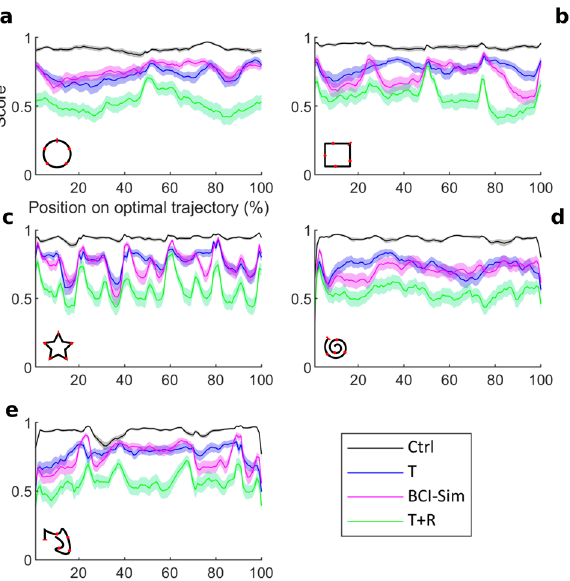
Figure 7. All participants’ mean scores across the target shape. The mean score is shown against the position on the optimal trajectory in percent (see Material and Methods). The data is shown for the Circle ( A ), Square ( B ), Star ( C ), Spiral ( D ) and the custom asymmetrical shape ( E ). For each plot, a symbol indicating the shape is shown in the lower left corner. The respective shapes starting position is marked with a red bar in these symbols. Scores are shown in black for control condition, blue for translation condition, magenta for BCI-Sim and green for T + R condition. The error indicates S.E.M.